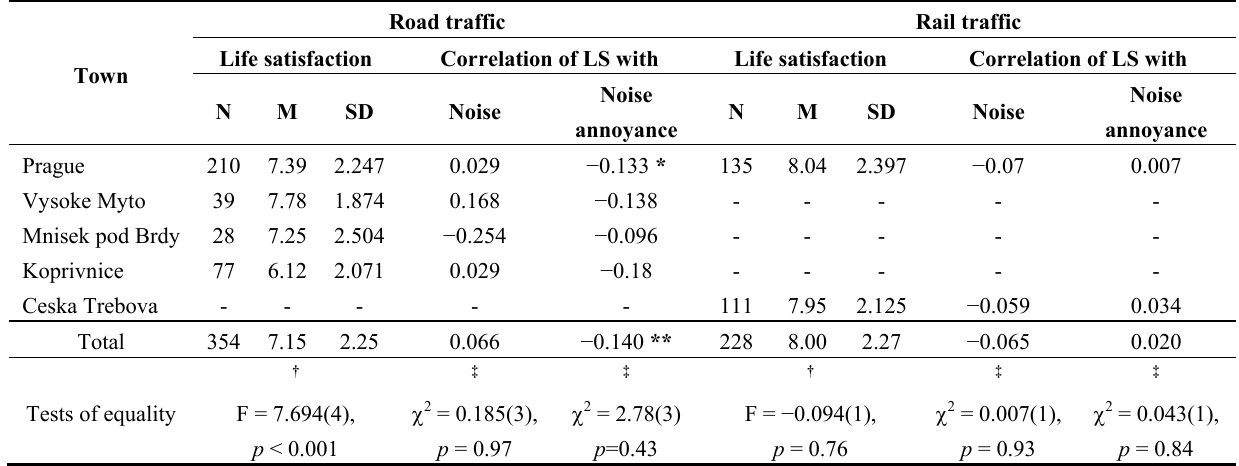
Table 3. Life satisfaction in sub-samples from different cities. Road traffic Rail traffic Life satisfaction Correlation of LS with Life satisfaction Correlation of LS with Town Noise Noise